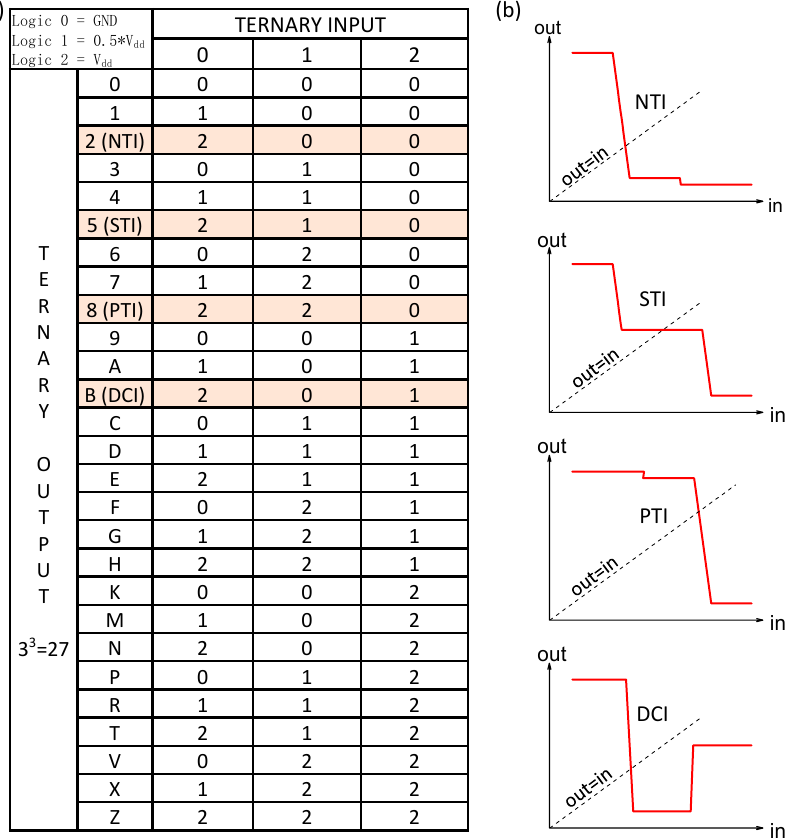
Figure 1. ( a ) List of the 27 ternary operators. ( b ) Characteristic curves of ideal negative ternary inverter (NTI), standard ternary inverter (STI), positive ternary inverter (PTI) and decrement cycling inverter (DCI) from top to down.